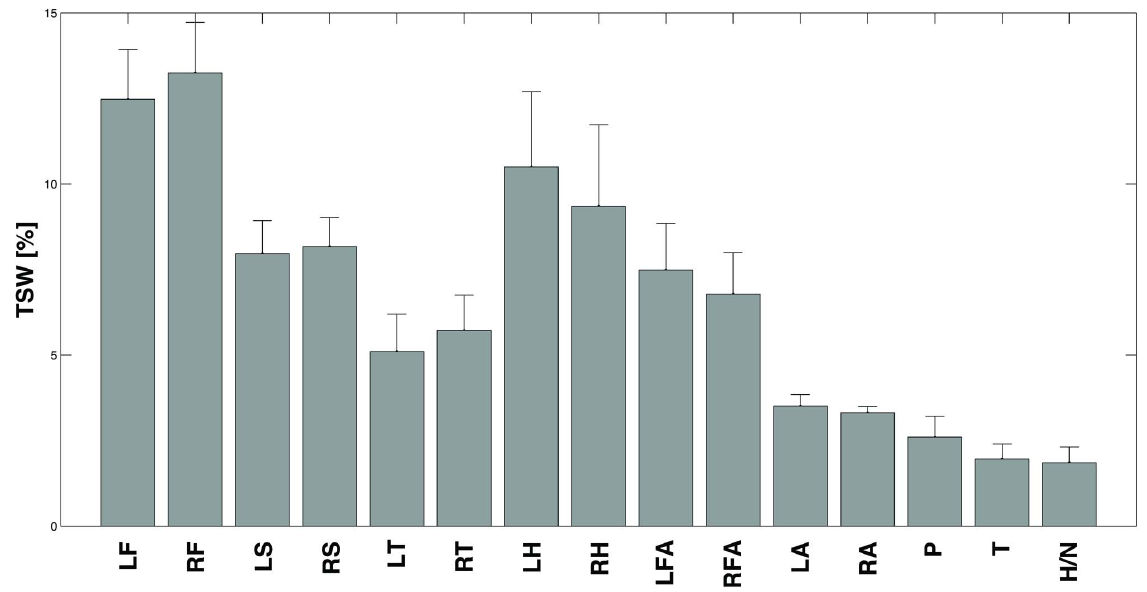
Figure 4. Total Segment Weight. The Figure shows the mean and one standard deviation (error bar) of the Total Segment Weight ( TSW ) of each body segment that is the cumulative weight of the accounted segment on the ICs extracted. The TSW was normalized and expressed as a percentage. The 15 segments are: head/neck ( H/N ), chest ( T ), abdomen/pelvis ( P ), upper arms ( LA and RA ), forearms ( LFA and RFA ), hands ( LH and RH ), thighs ( LT and RT ), shanks ( LS and RS ) and feet ( LF and RF ). See Appendix S1 for further details.